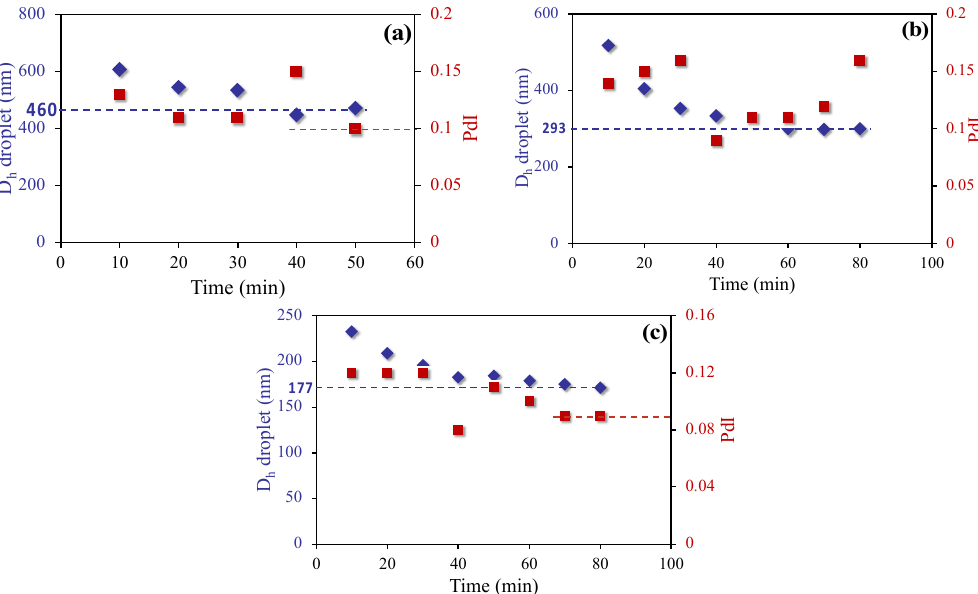
Figure 3. Evolution of droplet diameter as a function of time for styrene miniemulsions prepared using the ultra-turrax (rotational speed at 20,000 rpm) as emulsification device and hexadecane (HD) as the hydrophobe. ( a ) 1.5 wt.% of SDS ( b ) 3 wt% of SDS, and ( c ) 3 wt% of in situ generated K-oleate.